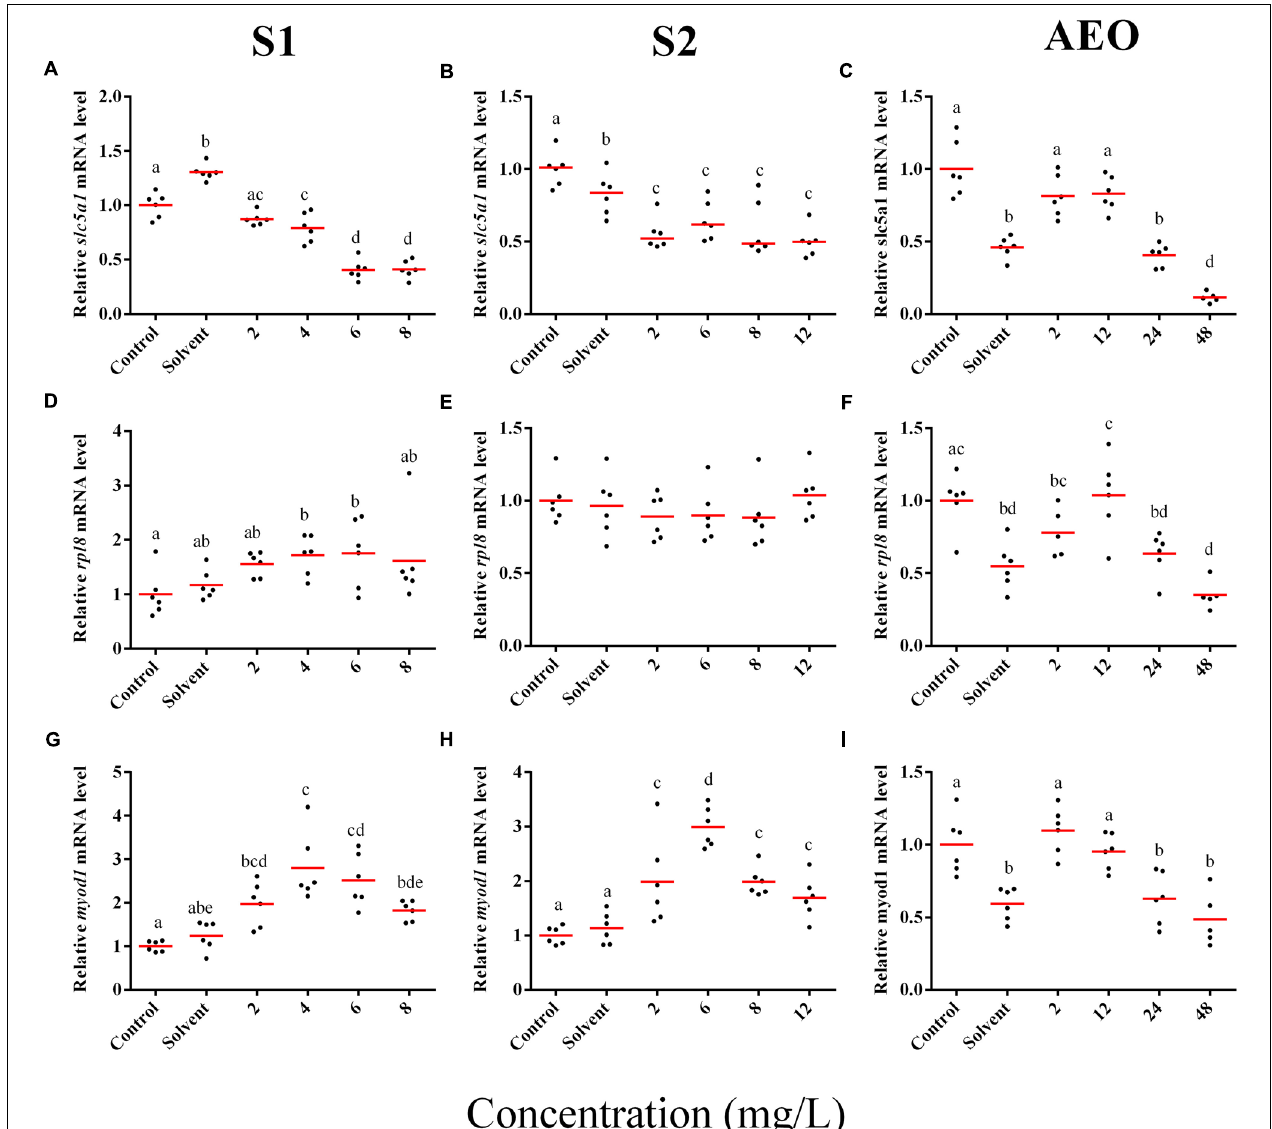
FIGURE 6 | RT-qPCR analysis for slc5a1 (A–C) , rpl8 (D–F) , and (G–I) myod1 mRNA in S. tropicalis exposed to different concentrations of S1 (first column), S2 (second column), and AEOs (third column). Data were normalized and defined as fold change relative to control. Different letters indicate groups that are significantly different ( p <